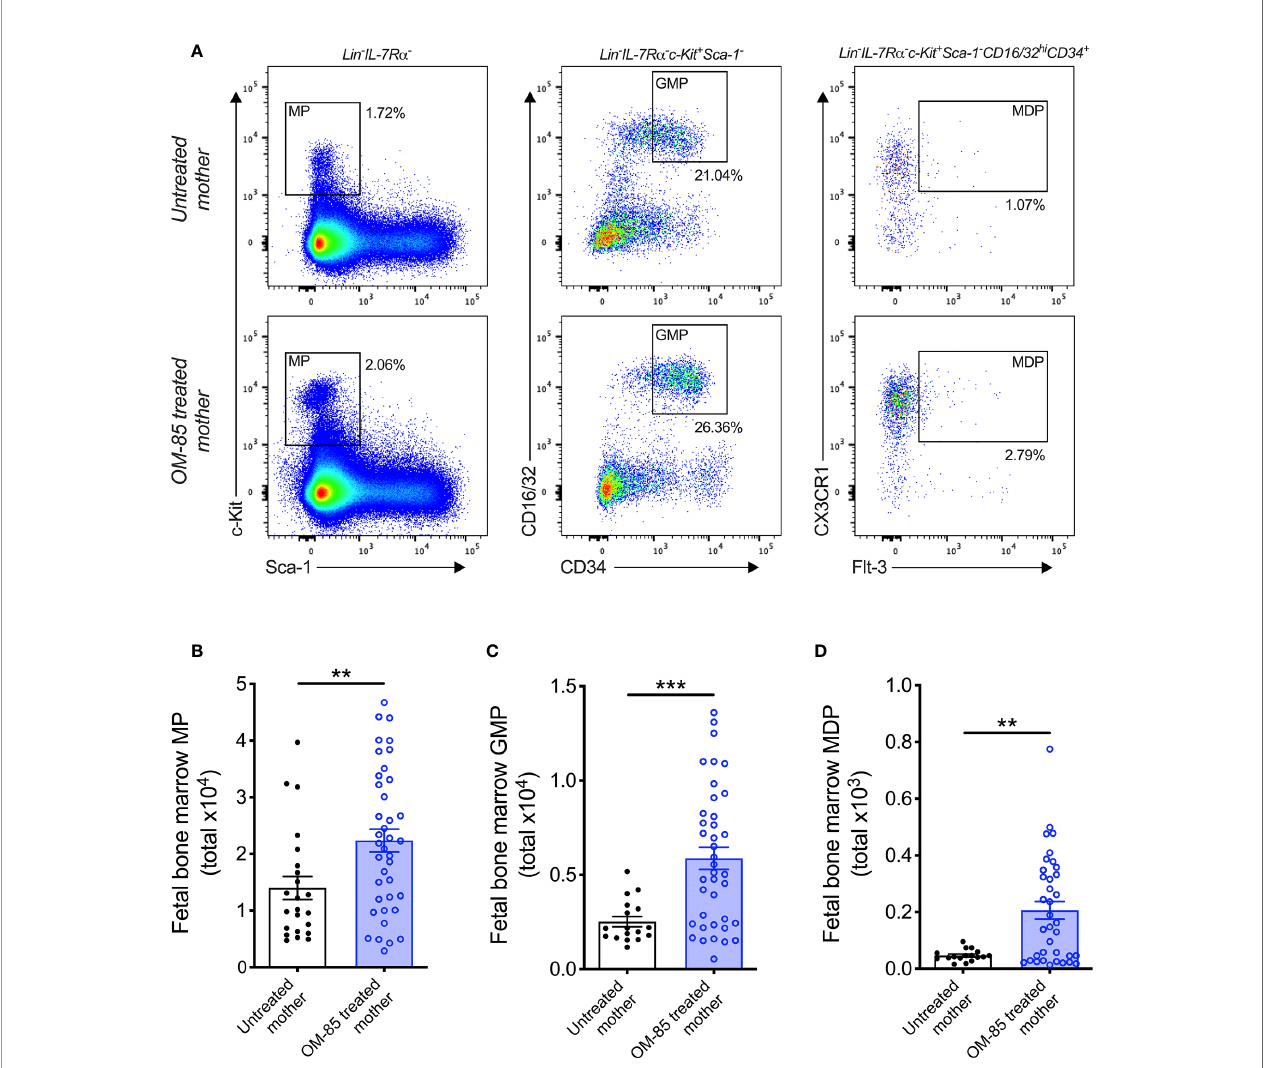
FIGURE 2 | Treatment of mothers with OM-85 during pregnancy boosts myeloid progenitor subsets within fetal bone marrow. (A) Representative fl ow cytometry plots for the identi fi cation of MP, GMP and MDP within fBM. Absolute numbers of (B) MP, (C) GMP and (D) MDP in BM of fetuses from OM-85-treated and untreated mothers. Data are presented from individual animals comparing fetuses from OM-85-treated and untreated mothers and displayed as bar graphs showing mean ± SEM of n = 8 independent experiments, with each experiment containing fetuses from 1 untreated and 1 OM-85 treated mother. Statistical signi fi cance was determined using Student ’ s t test (C) or Mann-Whitney U test (B, D) based on distribution of the data as determined by D ’ Agostino-Pearson omnibus normality test. **p < 0.01, ***p <